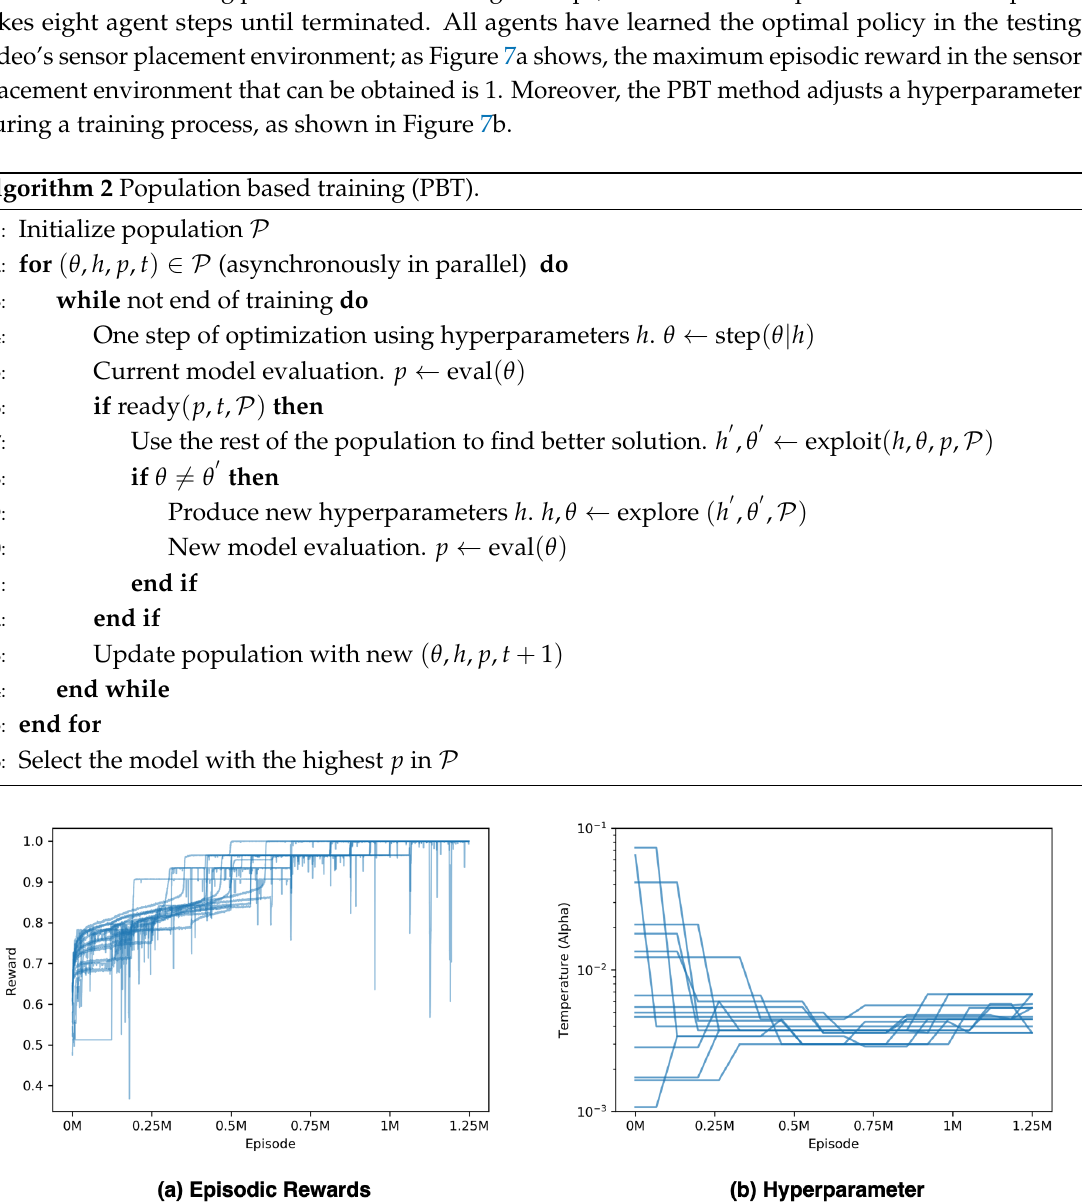
Figure 7. Illustration of tuning temperature hyperparameter with the PBT method. ( a ) is the episodic rewards for 15 agents and filtered with a moving average filter with a window size 1000; ( b ) displays each agent’s temperature hyperparameter with a log